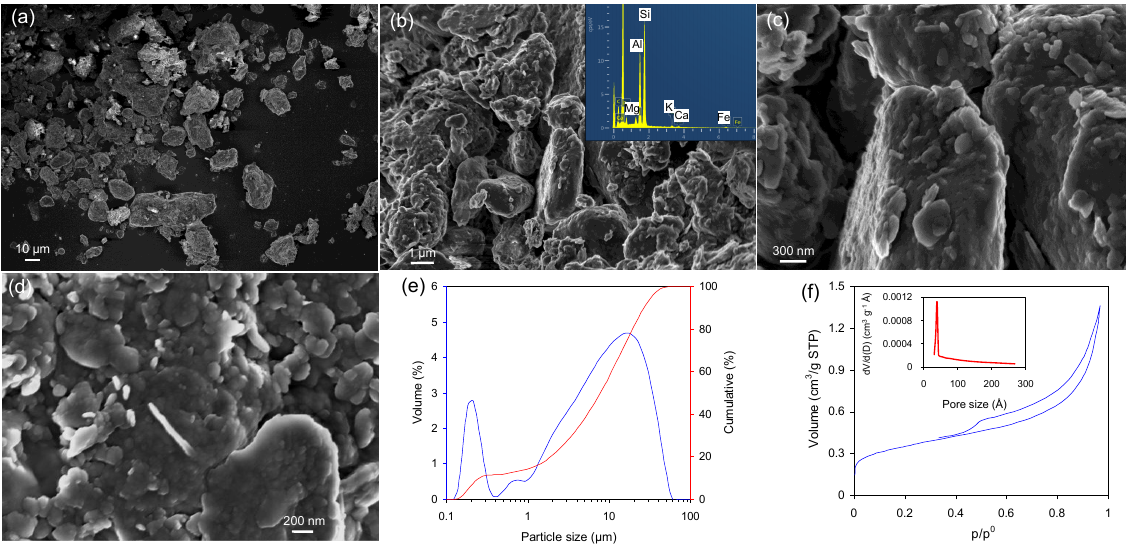
Figure 9. FESEM photomicrographs of Saharan dust particles. Large particles (a) are made up of smaller, micrometer-sized particles (b) which in turn are covered by nanoparticles (c) . (d) Detail of the nanogranular surface texture of dust particles. The inset in (b) shows a representative EDX spectrum (corresponding to the particle in the center of the image) showing a high content of Si, Al, and Mg, with small amounts of K, Ca, and Fe. Very similar spectra are recorded for most of the areas in the sample, demonstrating that the larger particles (quartz, carbonates, and minor amounts of feldspars) are covered by clays and iron oxyhydroxide (nano)particles. (e) Particle size distribution (vol% PSD and cumulative curves) and (f) nitrogen sorption isotherm of dust particles. The inset shows the BJH pore size